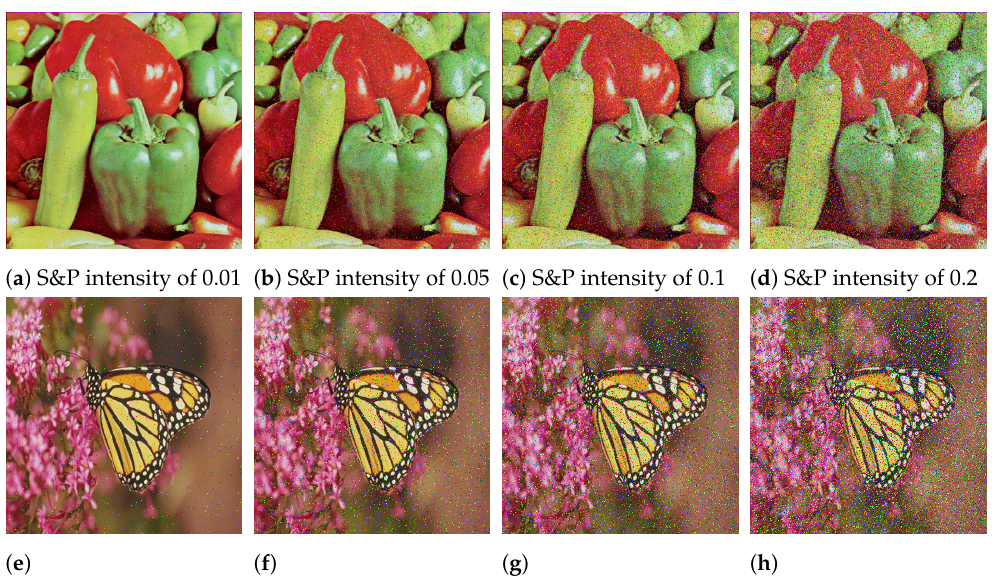
Figure 12. Outcomes of noise attacks ( e – h ) with various Salt and Pepper (S&P) noise intensities ( a – d ) appended to the encrypted image